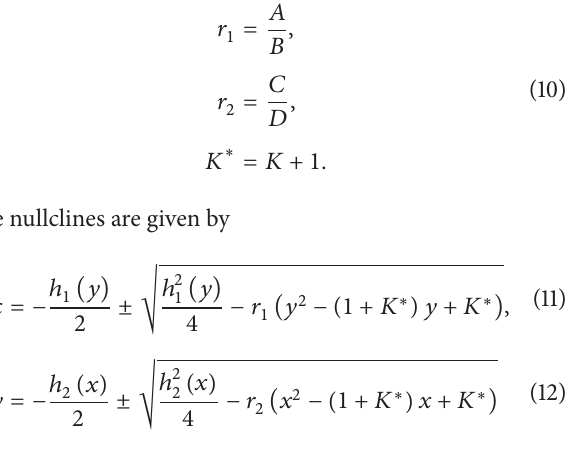
Figure 1: Nullclines as defined by (11) (dashed line) and (12) (solid line) for the monostable case. Parameters: 𝐾 = 0.01 (as in [10]) and 𝑟 = 0.7 . All parameters are in arbitrary units.